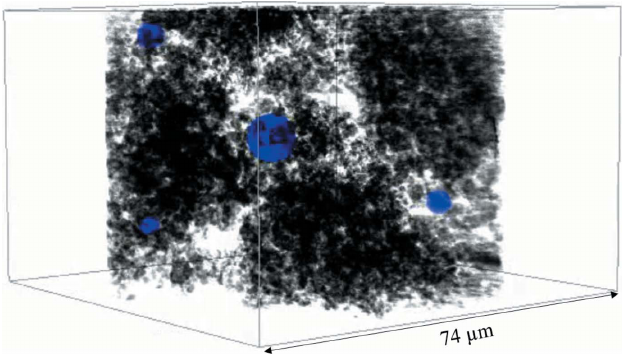
Figure 5 A 3D volume rendered image of the simulated MPL measured by X-ray nano-CT. Solid materials that comprise the hydrophobic pore structure are represented in black. The blue color corresponds to liquid water. Four spherical-shaped liquid water areas were observed in the pores (see Movie S1 of the supporting information).